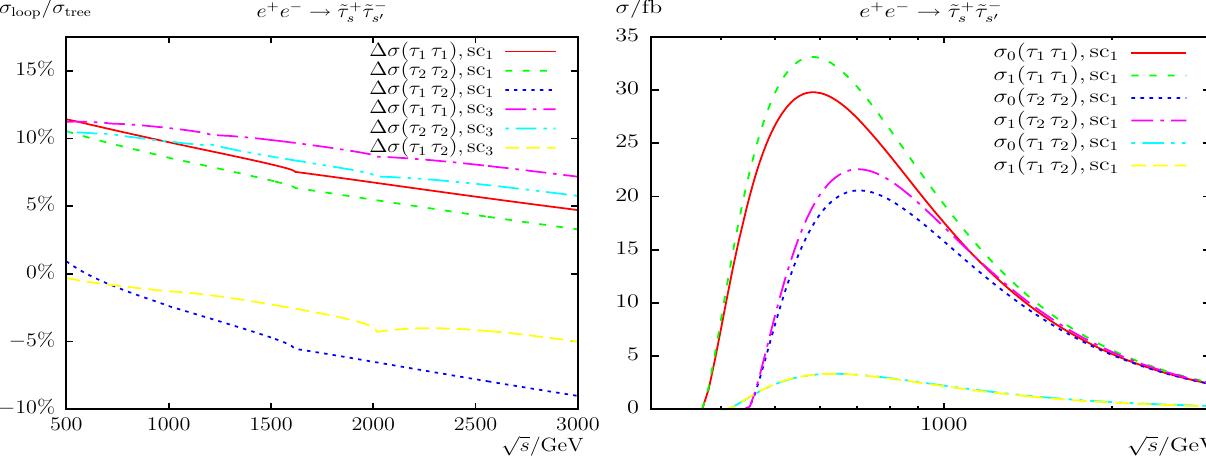
) . Total relative corrections (left) and tree-level and one-loop cross sections (right) as as s (cid:3)